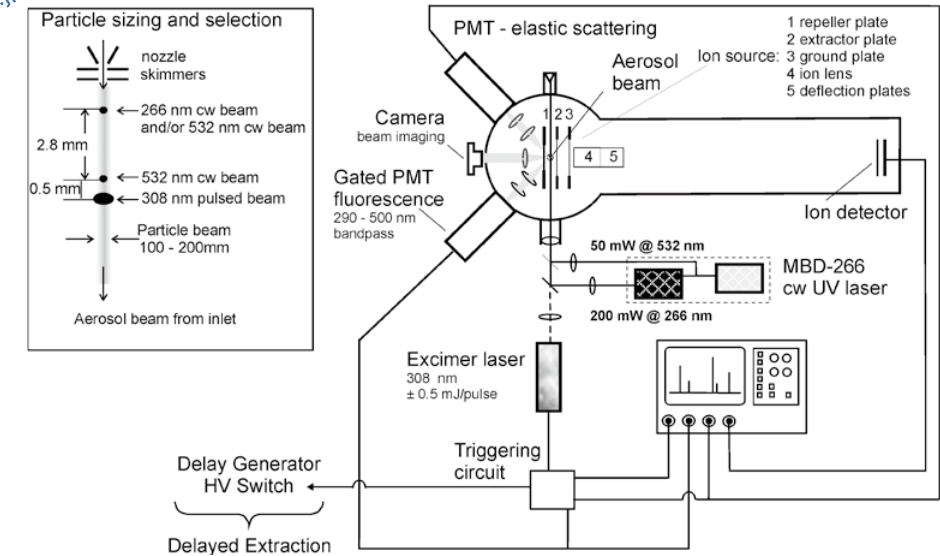
Fig. 1 Schematic diagram of the aerosol mass spectrometer and a cross-section of the particle sizing and detection re-